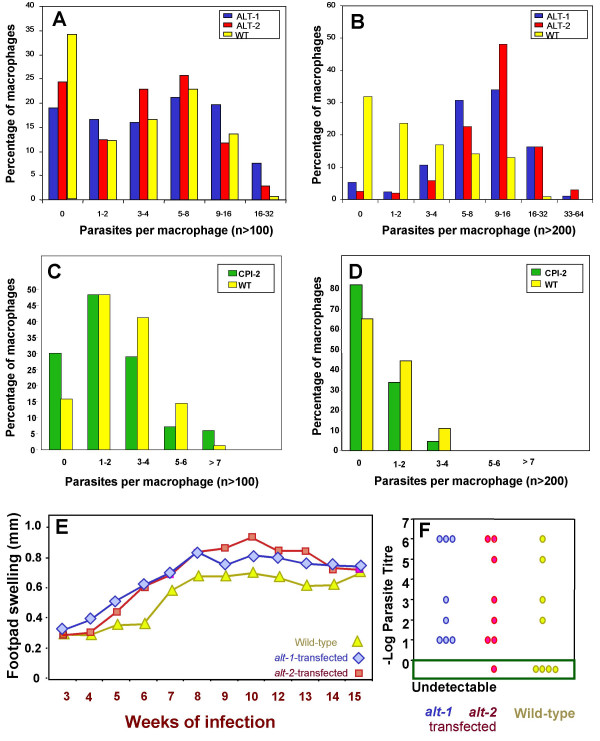
In vitro infection of macrophages with transfected amastigotes. (A, B). Bone marrow derived macrophages from CBA mice were infected for (A) 24 hours or (B) 7 days with wild-type or transfected amastigotes at a ratio of 10 parasites per macrophage. Parasites were detected and counted by immunofluorescence. Between 100 and 200 macrophages were counted for each time-point. The χ2 test showed significant differences in the numbers of infected vs uninfected macrophages between wild-type and either alt-1 or alt-2 transfectants at both time points (p < 0.001). (C, D). In vitro infection of macrophages with L. mexicana expressing the cysteine protease inhibitor-2 (CPI-2) gene of B. malayi (C) after 24 hours and (D) after 7 days. (E, F) Infection of C57BL/6 mice with transfected L. mexicana. (E) Time-course of lesion development in mice. Groups of 8 female C57BL/6 mice were injected subcutaneously in the footpad with 3 × 106 stationary-phase wild-type L. mexicana, alt-1 transfectants or alt-2 transfectants. Lesion size was measured weekly during the course of infection with a dial micrometer and expressed as the difference in size between the infected footpad and the contralateral uninfected footpad. One of two replicate experiments with similar results is shown; because data are not normally distributed (see for example recovery of wild-type parasites in panel F), standard error values cannot be applied. (F) Recovery of parasites from footpads at 15 weeks post-infection. The number of parasites in the footpad was estimated by limiting dilution assay. Results are expressed as log10 of the highest dilution containing parasites.